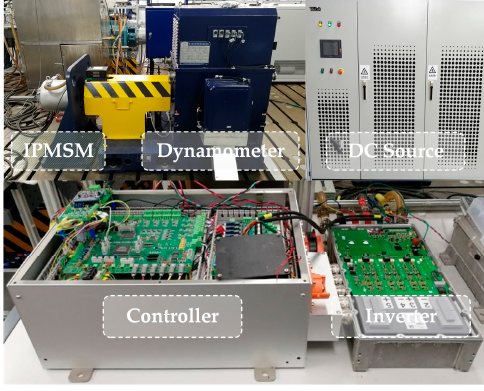
Figure 5. The experiment platform. Table 1. Parameters of the PMSM.